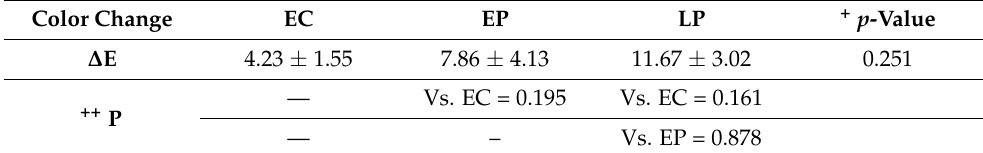
Table 4. Toothbrushing effect on the color change ( ∆ E) of all tested materials.